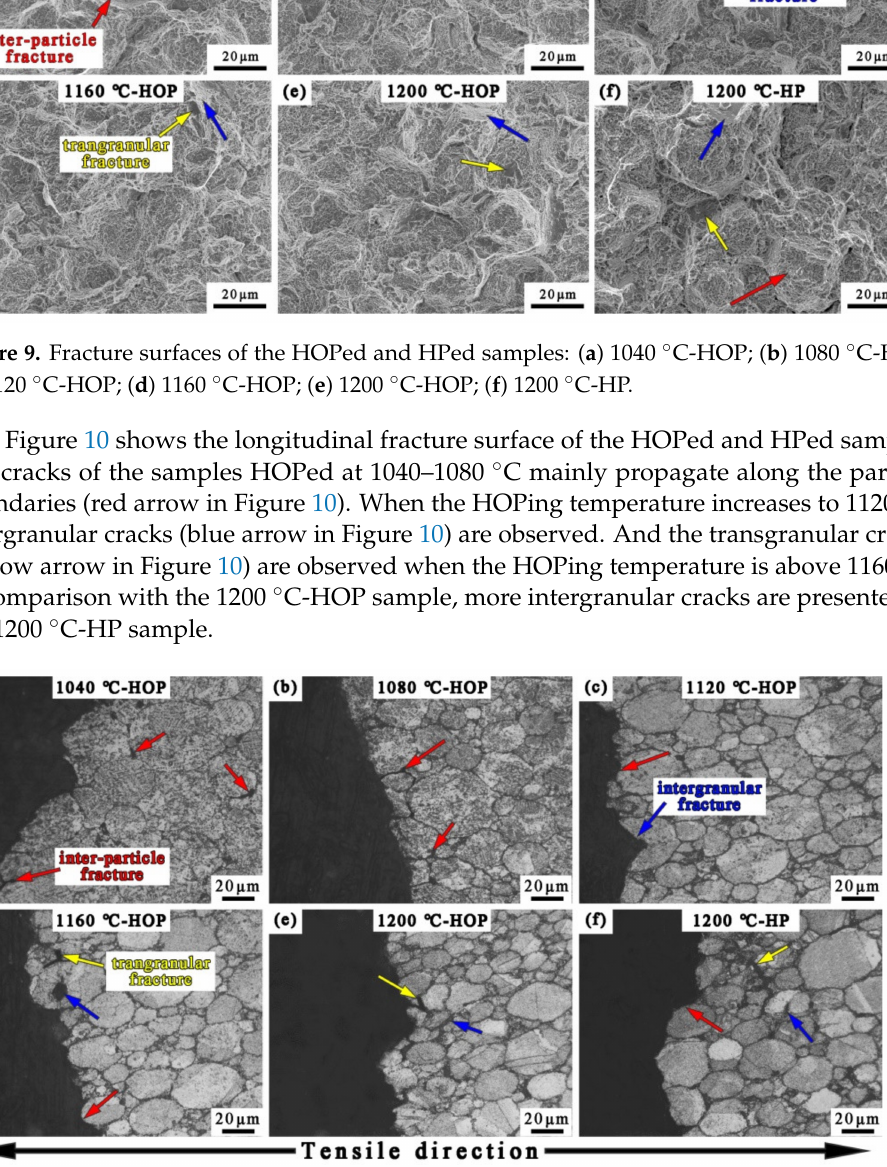
Figure 10. Microstructure nearby the longitudinal fracture surfaces of the HOPed and HPed sam- ples: ( a ) 1040 ◦ C-HOP; ( b ) 1080 ◦ C-HOP; ( c ) 1120 ◦ C-HOP; ( d ) 1160 ◦ C-HOP; ( e ) 1200 ◦ C-HOP; ( f ) 1200 ◦